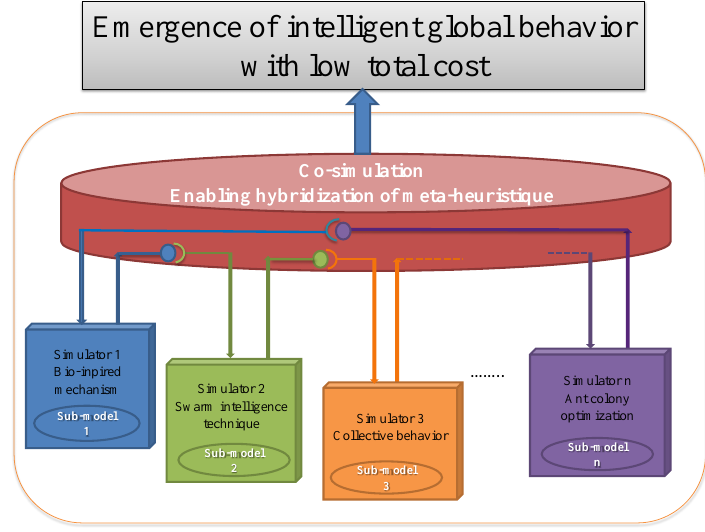
Figure 1. Co-simulation of coupled